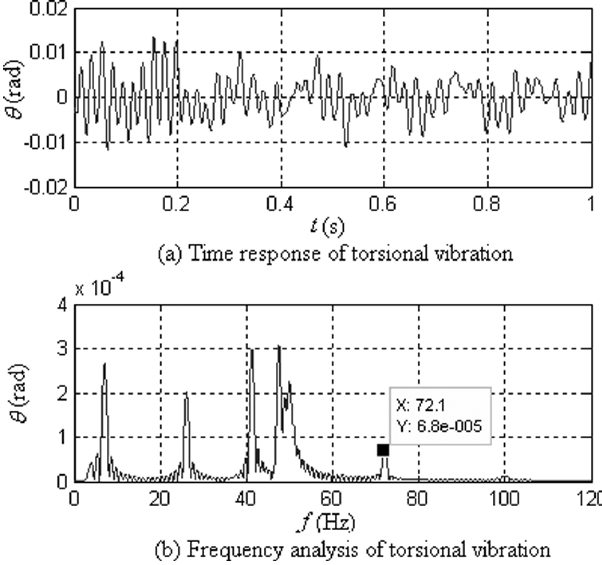
Fig. 8. Response and frequency analysis of the torsional vibration under the two-phase